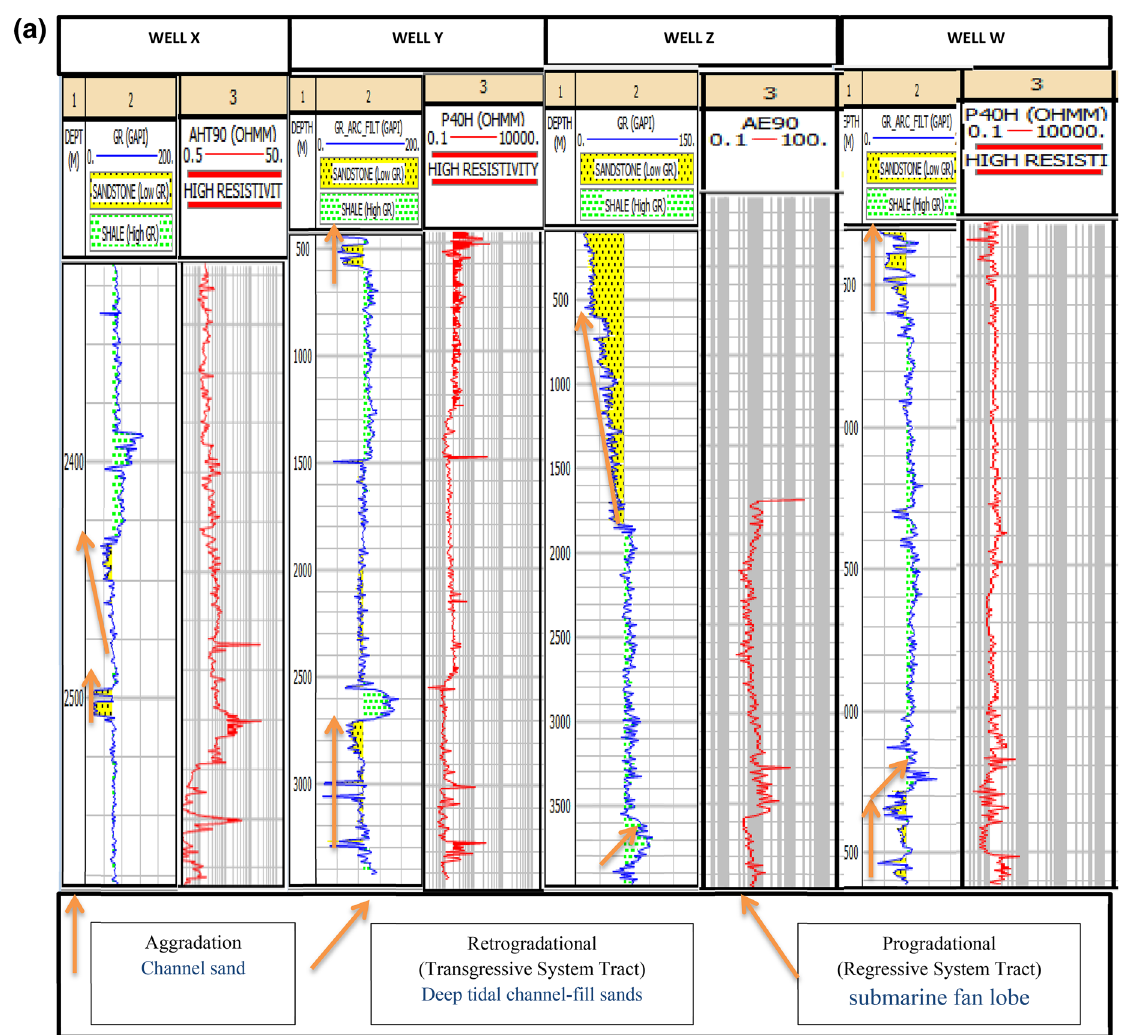
Fig. 4 a Analyzed wells depicting the various lithologies based on GR signature as well as the depositional system tracts deduced from GR response adopted from Kendall (2003), Rider (1996) and Emery